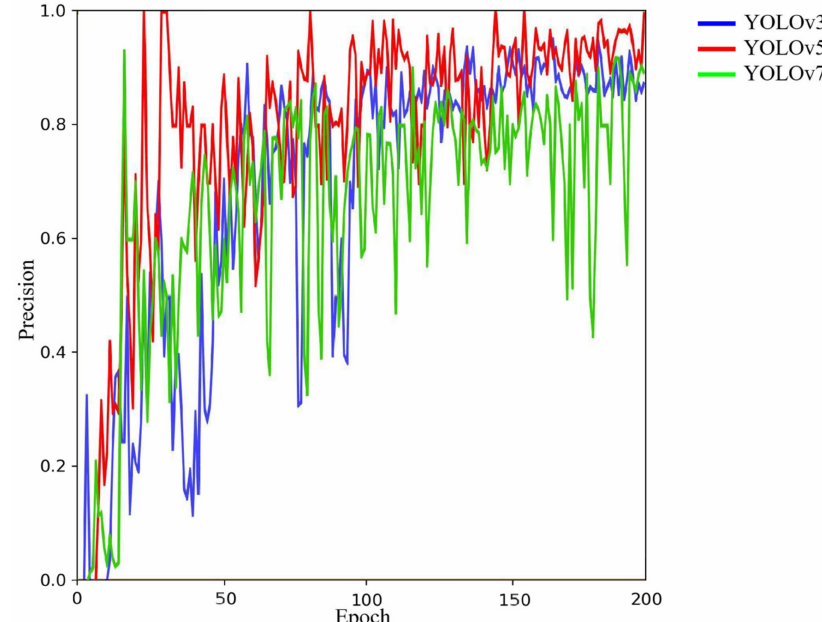
Figure 11. Precision curve.